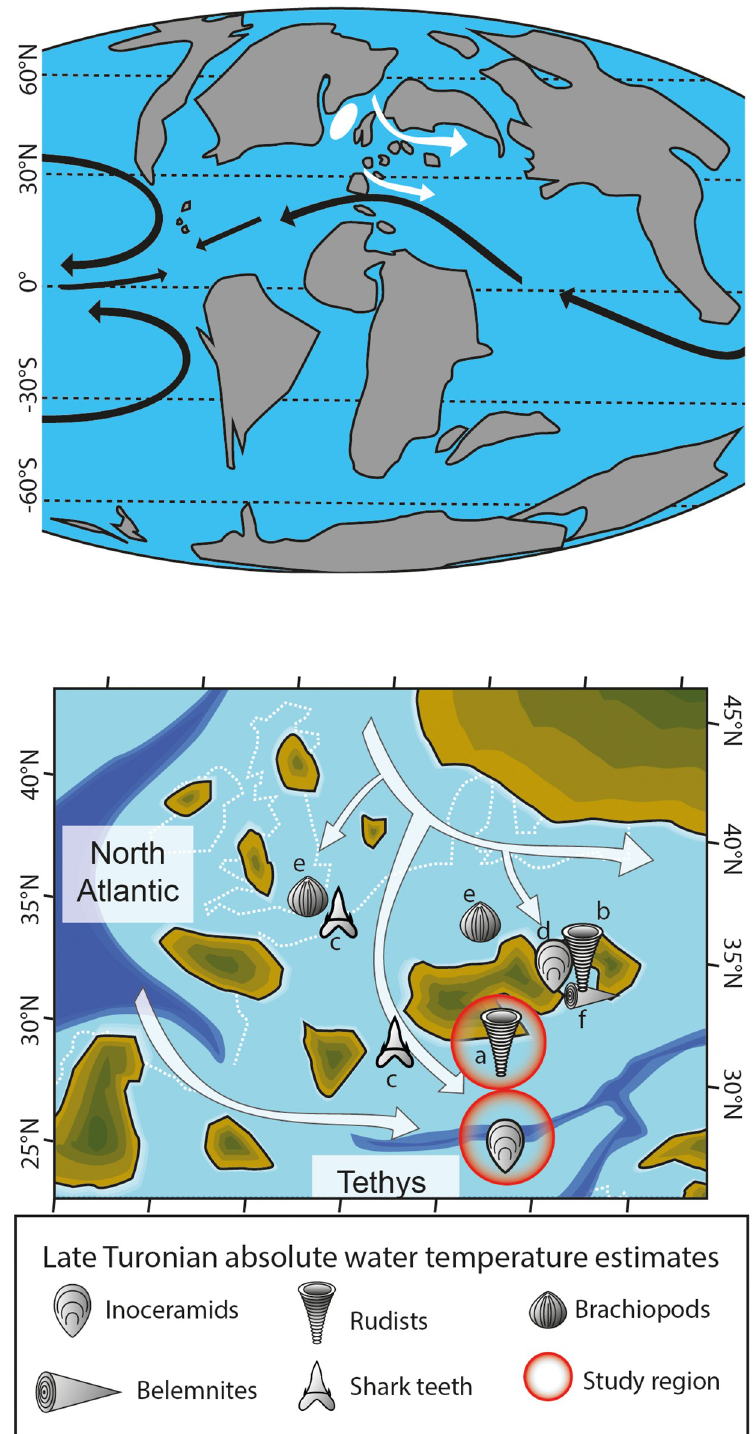
Fig 1. Simplified paleogeography of Earth and the northwestern margin of the Tethys during the late Turonian- early Coniacian interval. (A) Global paleogeography during the Late Turonian (modified from [62]) showing the patterns of the main surface oceanic currents (black arrows). The location of the deep water formation site in the North Atlantic (white circle) [14] and inferred ingression paths of high latitude cold waters onto the Central European shelves and the northwestern Tethys (white arrows) are shown. (B) Paleogeography of the northwestern